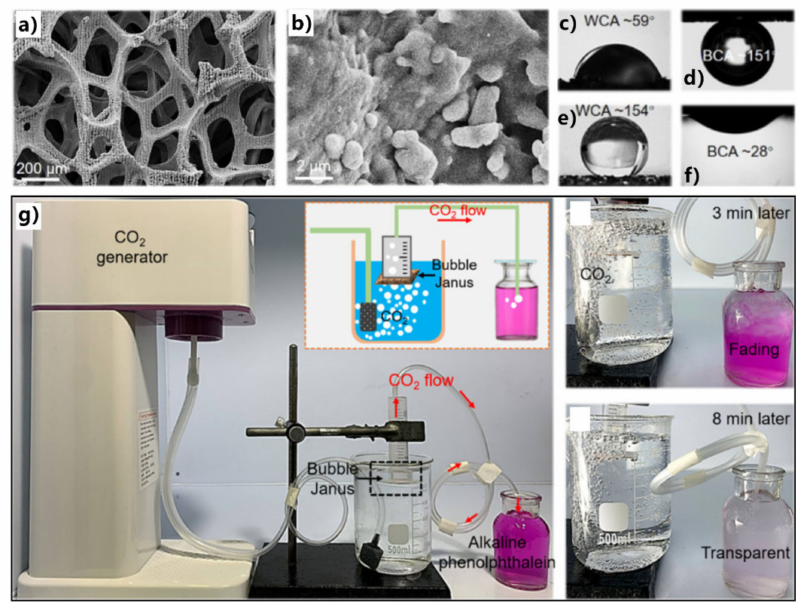
Figure 30. Collection of bubbles by a bubble Janus. ( a , b ) Microstructure of the laser-treated side of the copper foam. ( c ) Water droplet (in the air) and ( d ) underwater bubble on the laser-treated side of the foam. ( e ) Water droplet (in the air) and ( f ) underwater bubble on the untreated side of the foam. ( g ) Underwater carbon-capturing device based on the unidirectional bubble-transportation property of the Janus foam. Reprinted with permission from ref. [347]. Copyright 2020, American Chemical